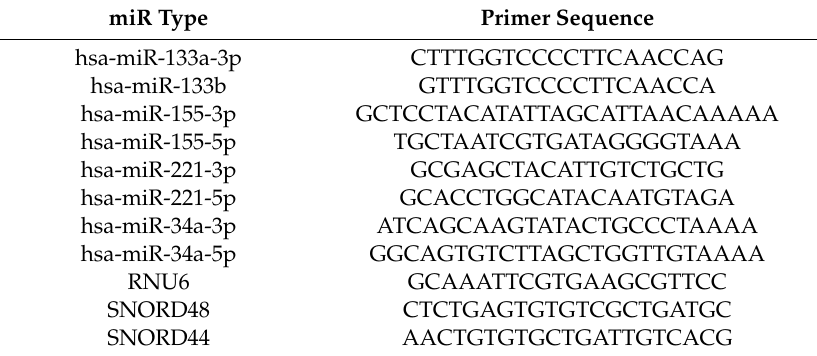
Table 1. Primer sequences of di ff erent microRNAs.